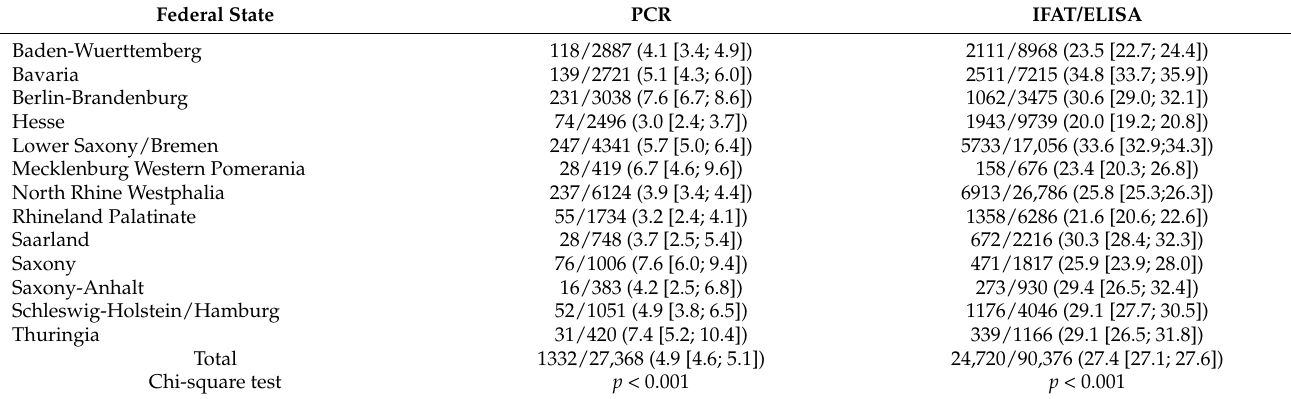
(Table 4). The highest rates of dogs with positive PCR results were found in Berlin- Brandenburg (7.6%), Saxony (7.6%), and Thuringia (7.4%). The highest rates of dogs with detectable antibodies were seen in Bavaria (34.8%), Lower Saxony/Bremen (33.6%), and the Saarland (30.3%). A Supplementary File S1 demonstrates percentages of dogs that tested positive for A. phagocytophilum by PCR and antibody testing per year for all individual federal states [see Supplementary File S1]. Table 4. Number of positive tests in dogs including direct and indirect detection methods of Anaplasma phagocytophilum in dogs living in Germany sorted by federal states of the submitting veterinarians ( n positive/ N total (% [95% CI lower limit; 95% CI upper